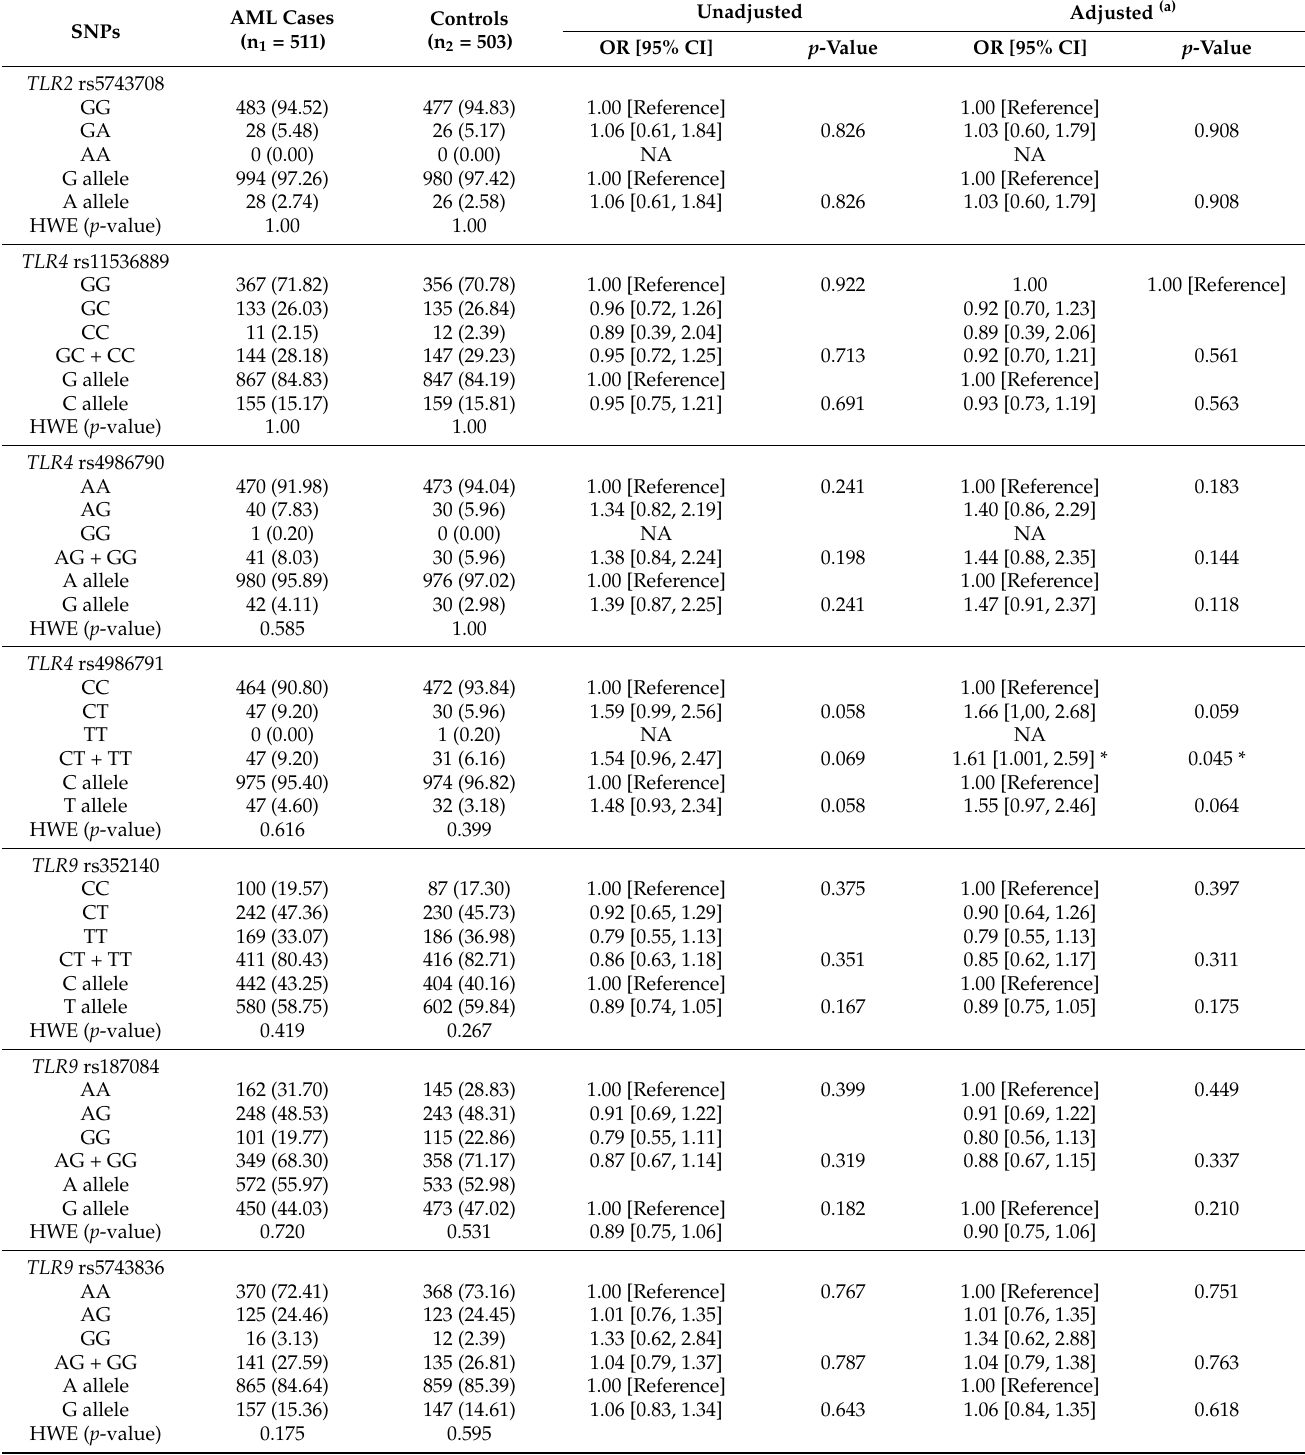
Table 1. Association analysis between variant genotypes/alleles of investigated TLR SNPs and odds of